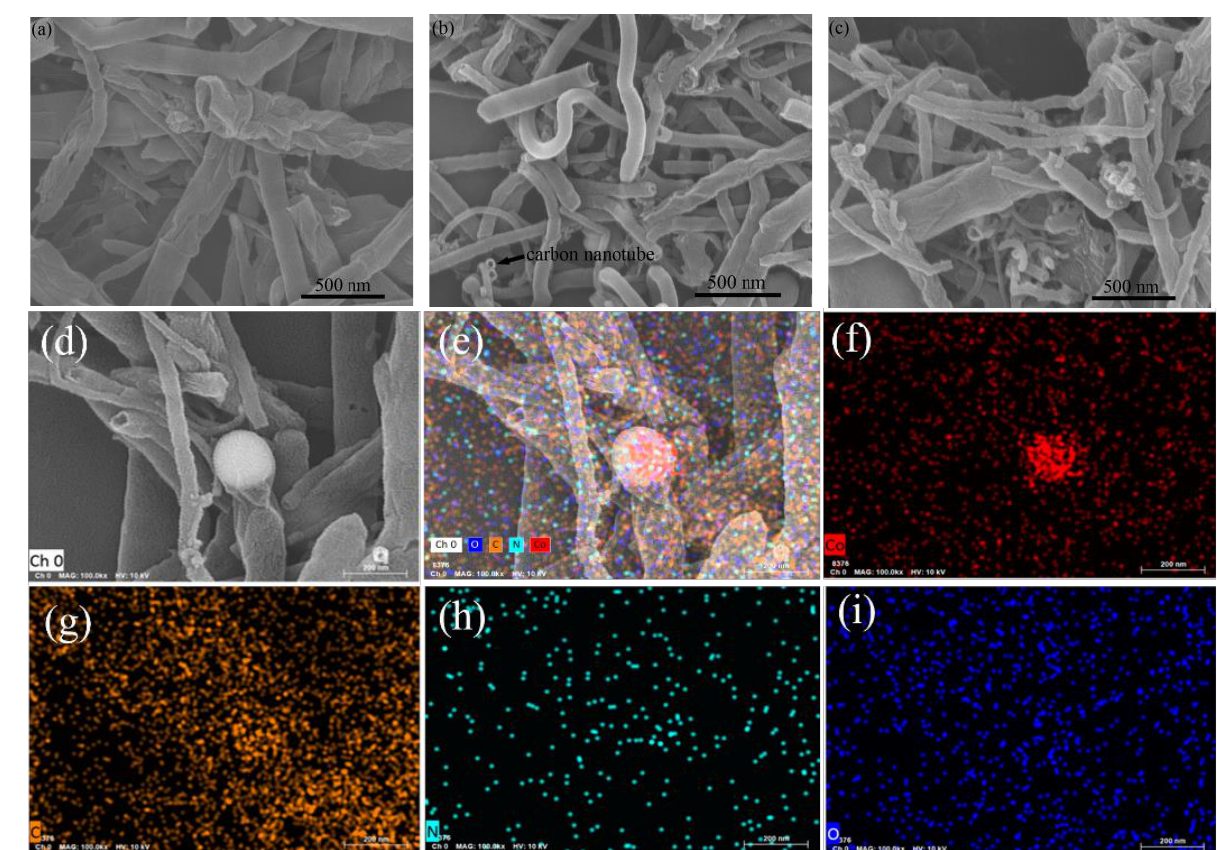
Figure 3. SEM images of Co−N−CNTs synthesized at different temperatures: ( a ) 700 °C, ( b ) 800 °C and ( c ) 900 °C; ( d , e ) EDS mapping images, ( f ) Co, ( g ) C, ( h ) N and ( i ) O of Co−N−CNTs at 800 °C.